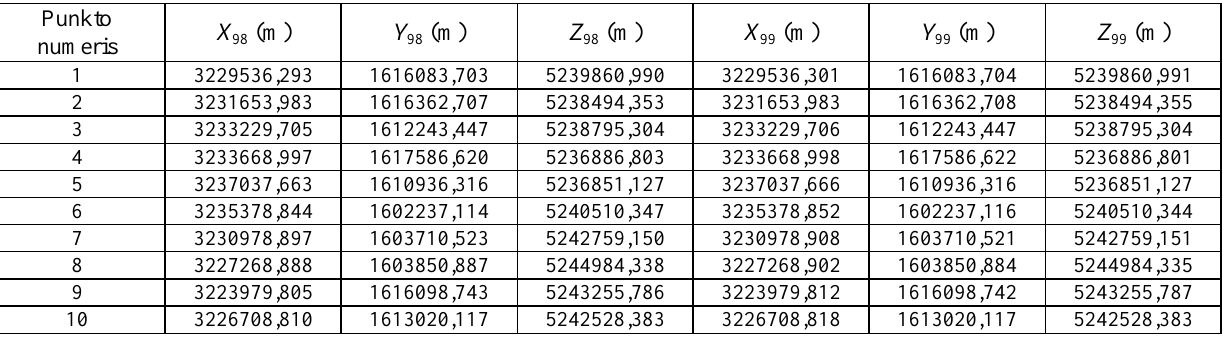
Table 1. Spatial rectangular geocentric coordinates of points (ETRS 89)